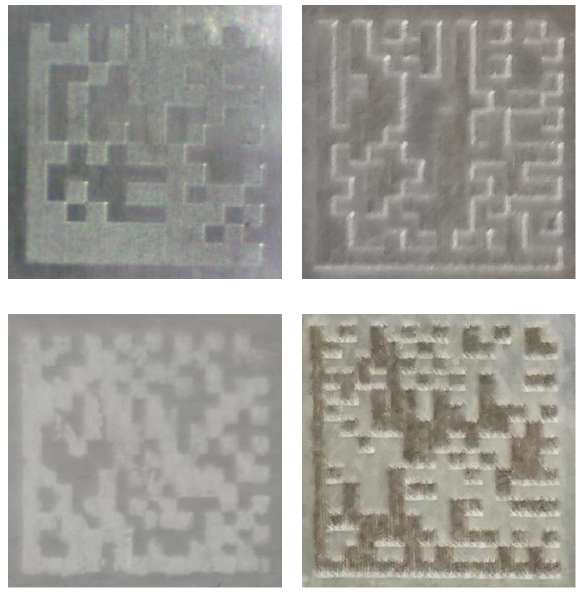
Figure 14. Some samples of our database.